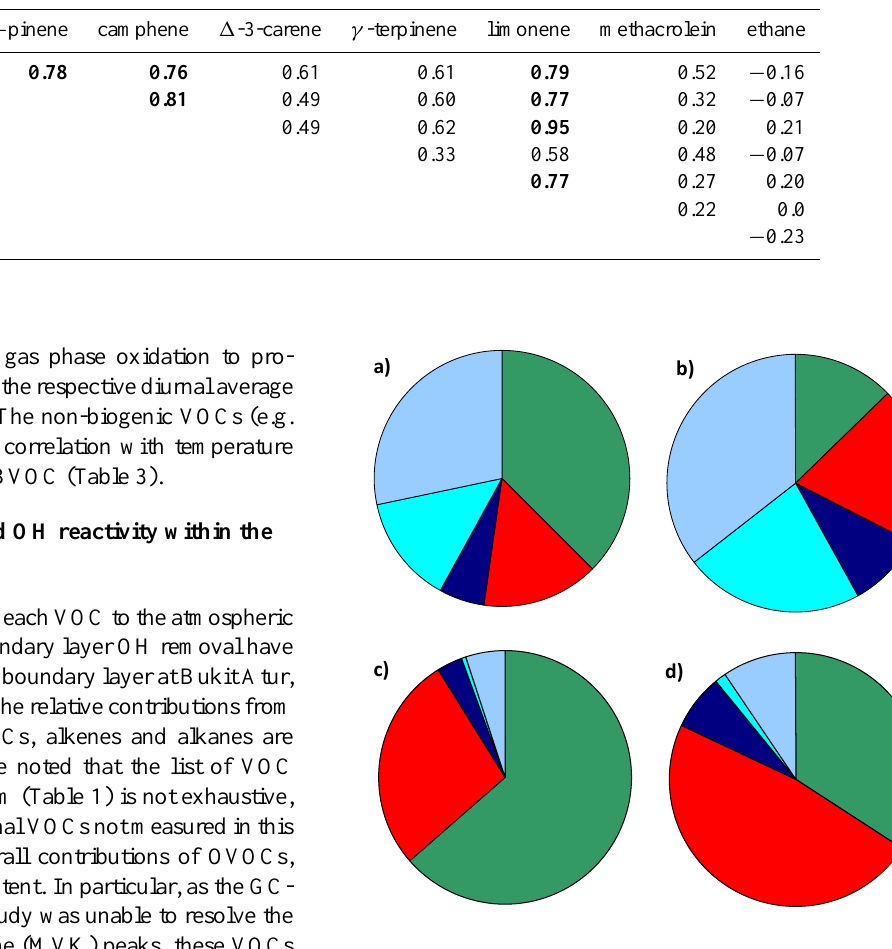
Fig. 7. Plots (a) and (b) represent the average instantaneous fraction of the total volatile organic carbon comprised of isoprene, monoterpenes, alkenes, alkanes and OVOCs in ground-level air at Bukit Atur, during the day (06:00a.m.–06:00p.m.; a ) and night time (06:00p.m.–06:00a.m.; b ). Plots (c) and (d) demonstrate the relative VOC reactivity with respect to OH for each VOC class during day time (c) and at night (d) , based upon the rate constants from Atkinson et al. (1986); Atkinson (1997); Atkinson and Arey (2003). Around midday, isoprene supplied up to 70 % of boundary layer volatile organic carbon, while within an hour after sun- rise and before sunset, the contribution from isoprene was as little as 5 %. During the night, the absolute concentrations of isoprene, monoterpenes and OVOCs were reduced relative to the daytime, and the fraction of volatile organic carbon sup- plied as OVOCs and monoterpenes increased, to 35 % and 20 % respectively, while the isoprene contribution decreased, to 13